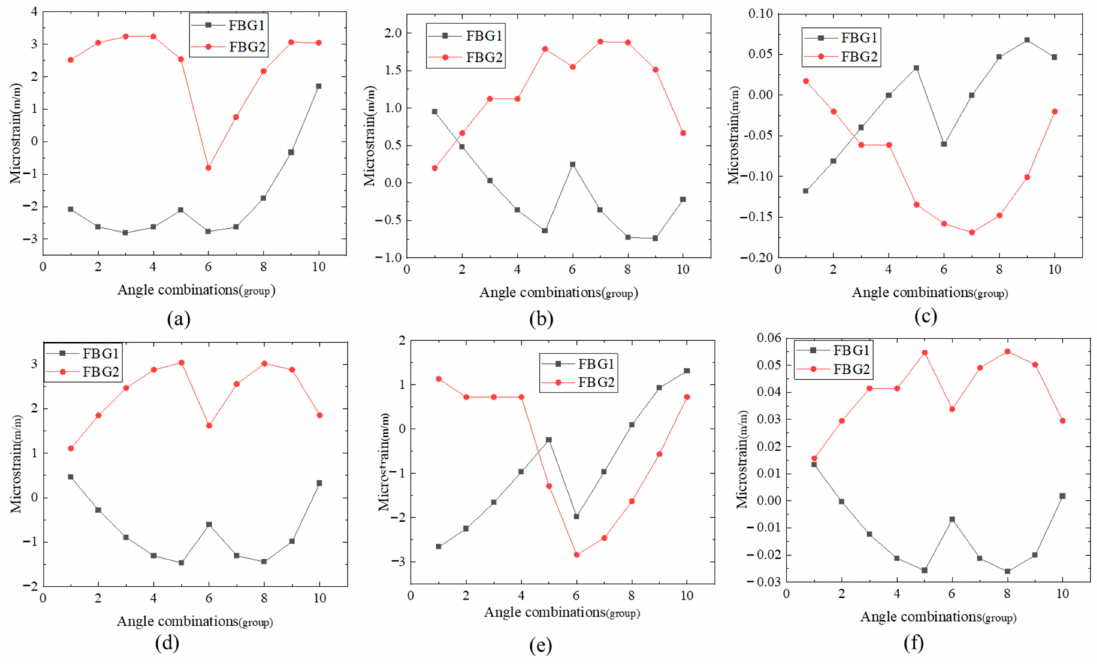
Figure 3. Double FBG strain variation diagram of measuring point 1: ( a ) Load loading mode 1; ( b ) Load loading mode 2; ( c ) Load loading mode 3; ( d ) Load loading mode 4; ( e ) Load loading mode 5; ( f ) Load loading mode